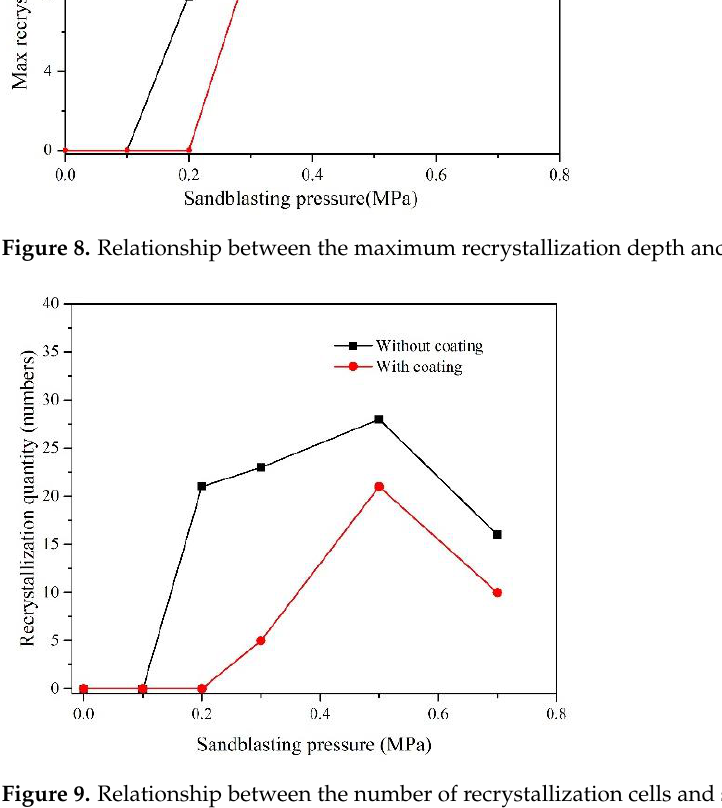
Figure 9. Relationship between the number of recrystallization cells and sandblasting pressure .